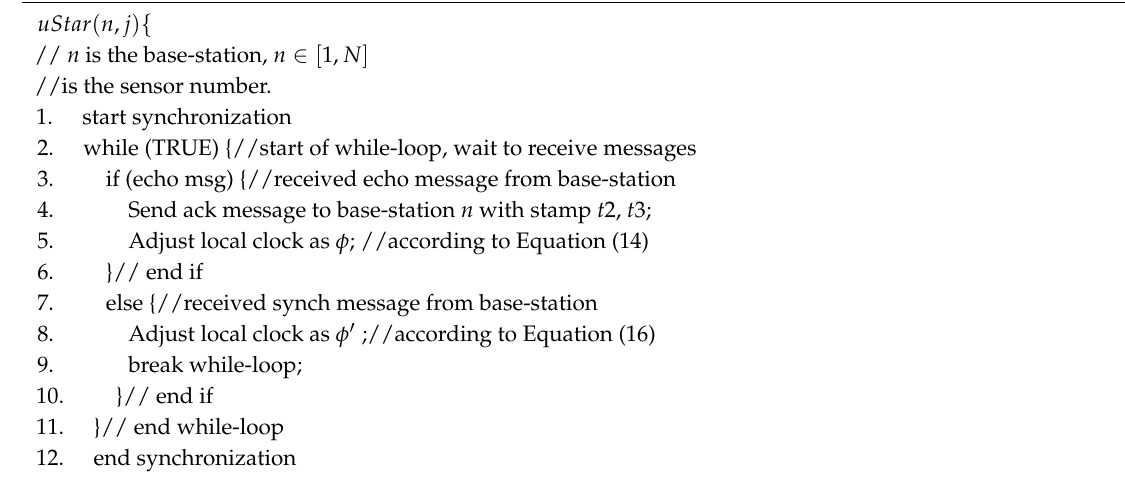
Algorithm 3. The clock synchronization algorithm for base-station to sensor: Part B: sensor. uStar ( n , j ) { // n is the base-station, n ∈ [ 1, N ] //is the sensor